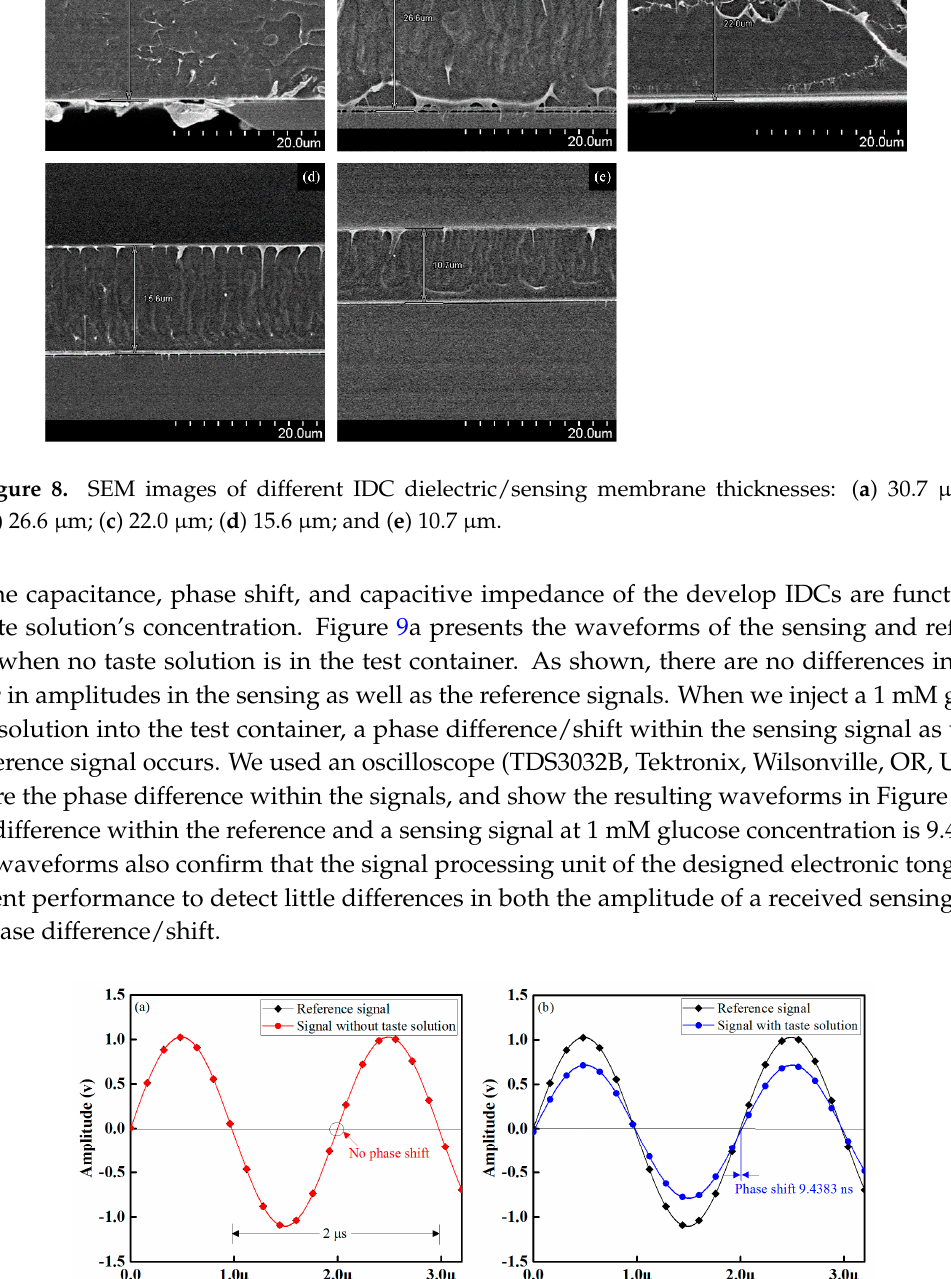
Figure 9. Waveform response of the designed electronic tongue: ( a ) response with reference solution (DI water) and ( b ) response with taste (glucose) solution.